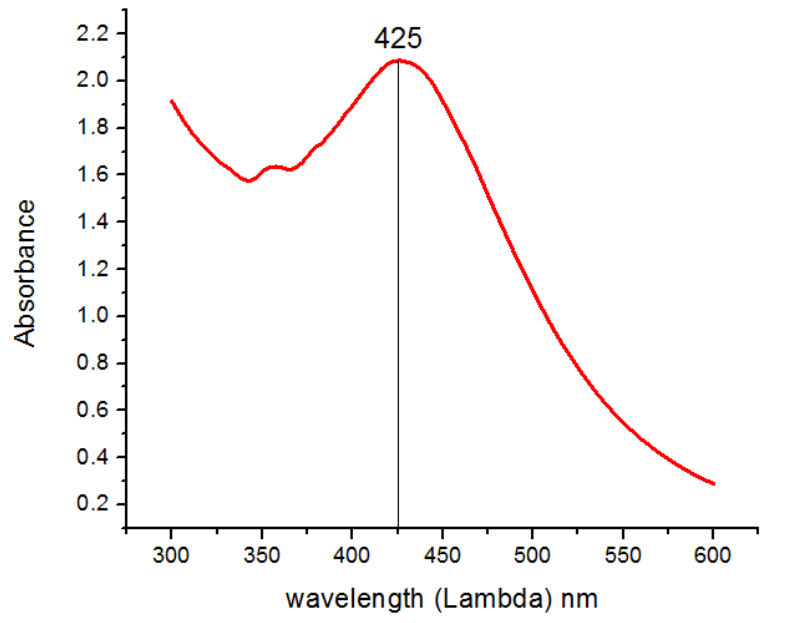
Figure 3. UV-Vis spectroscopy of reaction mixture indicating typical absorbance peak of AgNPs around 425